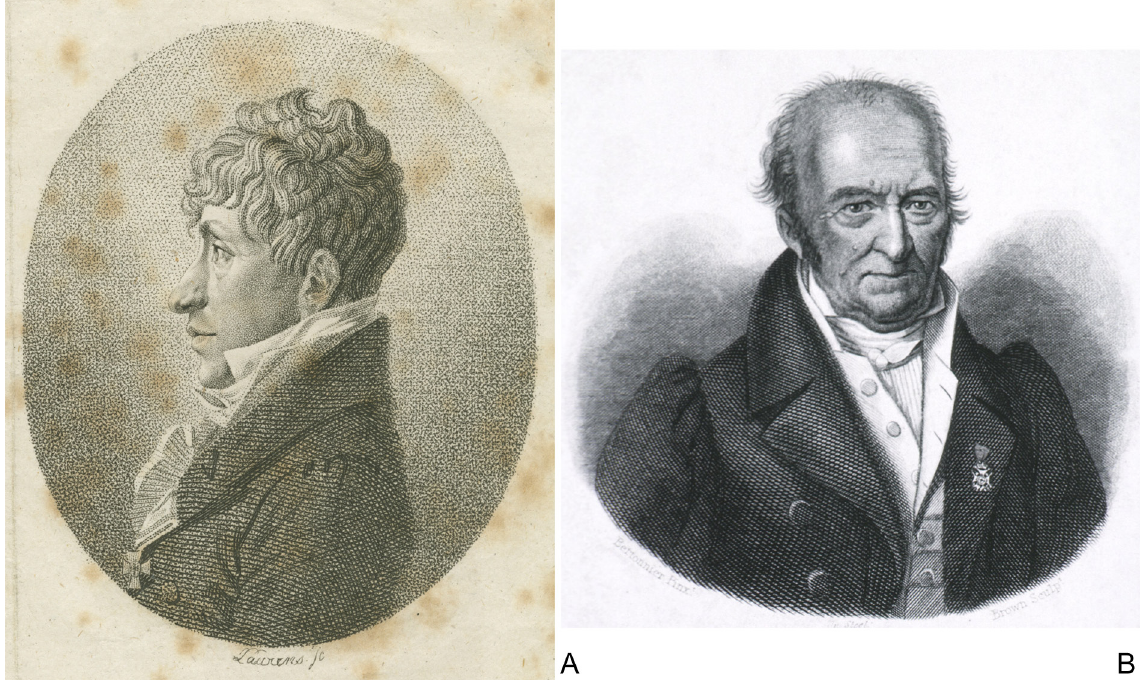
Fig. 1. Authors who initiated the studies on ‘ Canthon sensu lato’ in the first half of the 19 th century. A . The German naturalist Johann Centurius Graf von Hoffmannsegg (1766–1849), author of the genus Canthon (image courtesy of Editha Schubert, from the archives of the Senckenberg Deutsches Entomologisches Institut). B . The French entomologist Pierre André Latreille (1762–1833), author of Ateuchus septemmaculatus Latreille, 1807, species treated in detail by Hoffmannsegg (1817) in his description of Canthon . Latreille was also the author of Coprobius , name considered valid for decades before being synonymized with Canthon by Harold (1868a) (image courtesy of the United States National Library of